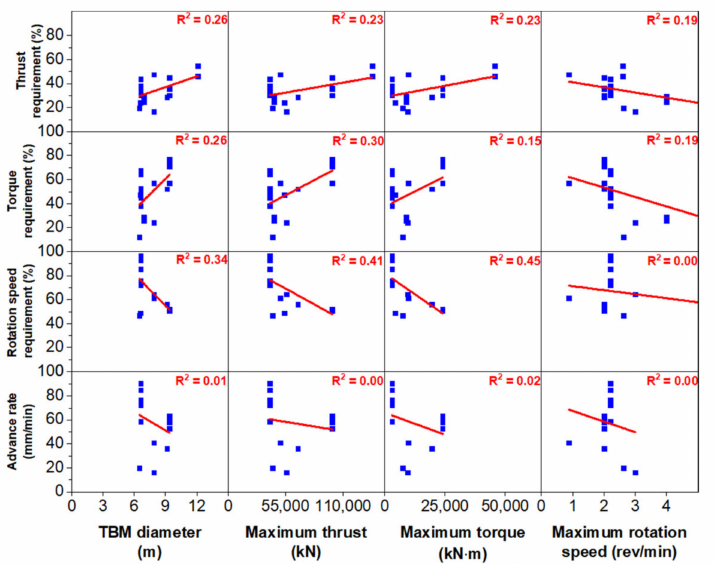
Figure 1. Scatter matrix for correlations of operating parameters’ requirements with TBM specifica-